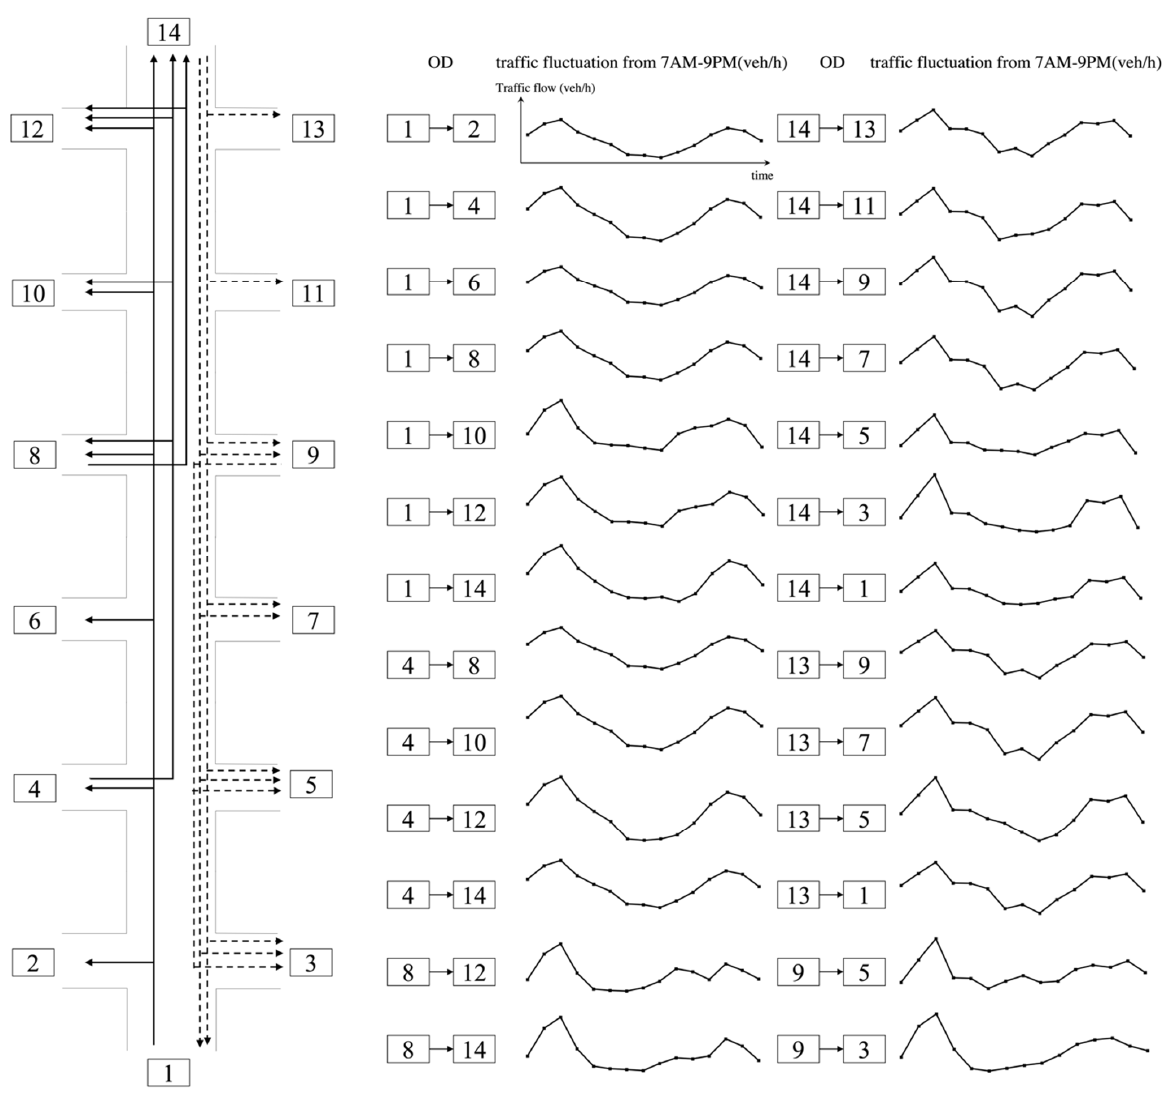
Figure 1. Flow fluctuations of different paths.